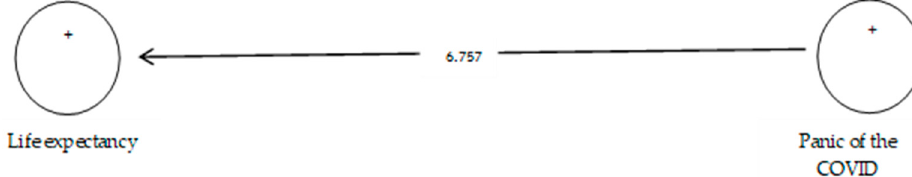
Figure 17. Drawn model with significant coefficients z. Table 11. Evaluation indicators of the internal model of the research, direction and significance of direct effects.